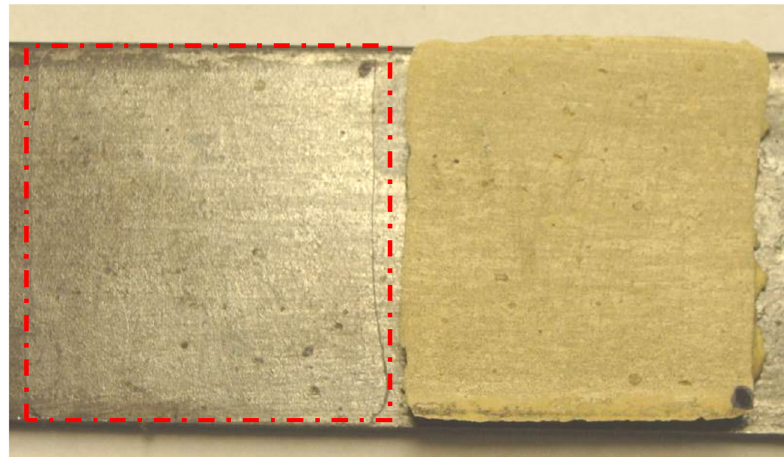
Figure 10: View of the surface of the sample and coating after the test – coating detached from the substrate, the red rectangle marks the place from which the coating has detached from the